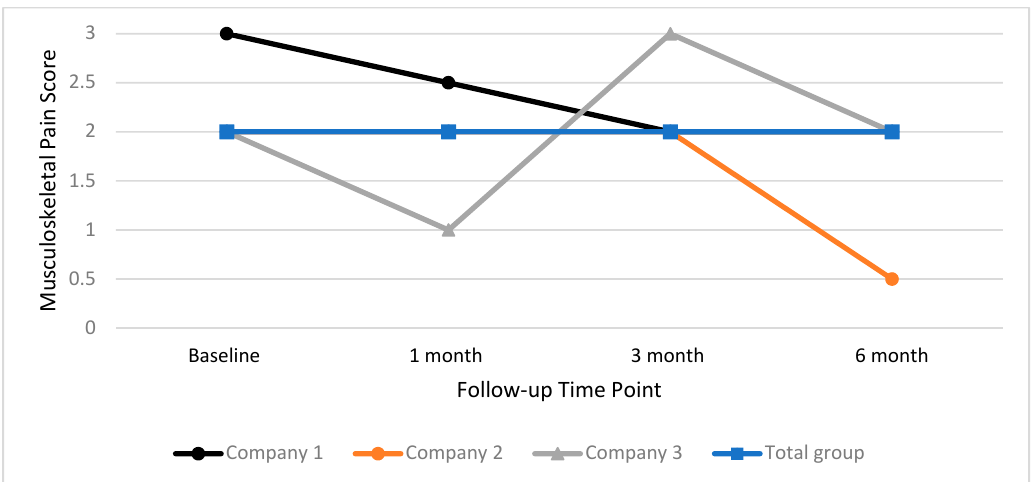
Figure 6. Median musculoskeletal pain score for total group and individual companies at baseline, one month, three month and six month time points.